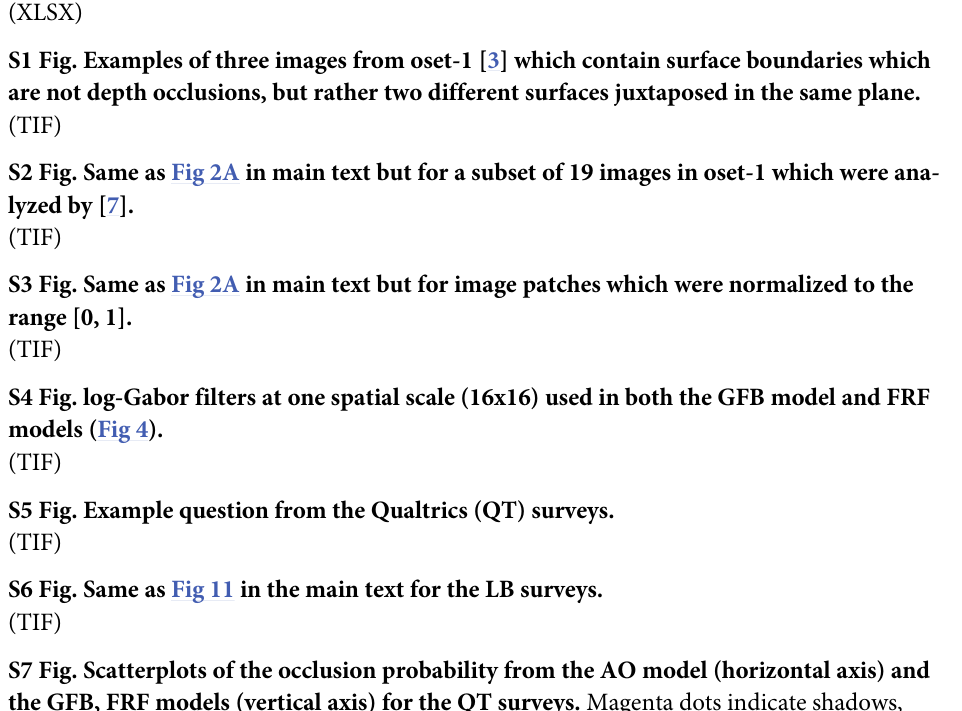
S9 Table. Same as S8 Table, but for oset-2. (XLSX) oset-1. (XLSX) S11 Table. Same as S10 Table, but for oset-2. (XLSX) S1 Fig. Examples of three images from oset-1 [3] which contain surface boundaries which are not depth occlusions, but rather two different surfaces juxtaposed in the same plane. (TIF) S2 Fig. Same as Fig 2A in main text but for a subset of 19 images in oset-1 which were ana- lyzed by [7]. S3 Fig. Same as Fig 2A in main text but for image patches which were normalized to the range [0, 1]. S4 Fig. log-Gabor filters at one spatial scale (16x16) used in both the GFB model and FRF models (Fig 4). S5 Fig. Example question from the Qualtrics (QT) surveys. S6 Fig. Same as Fig 11 in the main text for the LB surveys. S7 Fig. Scatterplots of the occlusion probability from the AO model (horizontal axis) and the GFB, FRF models (vertical axis) for the QT surveys. Magenta dots indicate shadows, green indicates occlusions. S8 Fig. Same as Fig 12 in the main text for the LB surveys. Magenta dots indicate shadows, green indicates occlusions. S9 Fig. Analysis of classification bias in individual human observers. ( a ) Distribution of the difference P ( o | S ) − P ( s | O ) in classification error probabilities for QT surveys. P ( o | S ) indicates the probability a shadow is misclassified as an occlusion, and P ( s | O ) is the probability of an occlusion being misclassified as a shadow (N = 54). ( b ) Distribution of the Wald statistic for the binomial proportion test testing whether there is a bias in misclassifications, with the null hypothesis of equal misclassification probabilities. ( c ) Scatter plot of classification error proba- bilities. ( d ) Same as (a) but for LB surveys (N = 45) ( e ) Same as (b) but for LB surveys. ( f ) Same as (c) but for LB surveys. S10 Fig. Decision-variable correlation analysis between models and individual observers for each experiment. Left : QT surveys. Center : LB surveys. Right : Pooled QT + LB